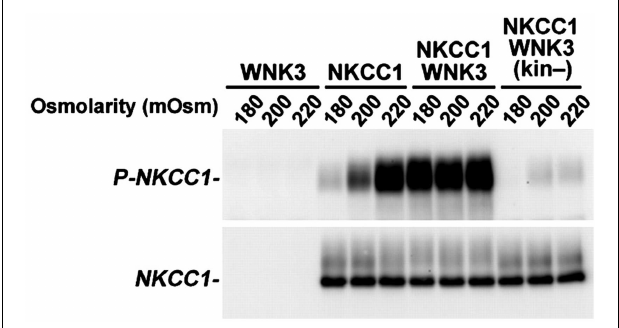
FIGURE 4 | Inhibition ofWNK3 kinase activity potently reduces stimulatory phosphorylation of NKCC1 .WNK3 regulates the phosphorylation of NKCC1. Xenopus oocytes were injected with the indicated cRNAs and incubated at varying extracellular osmolarities (180, 200, and 220mOsm). After incubation, oocytes were lysed, andWestern blotting was performed with probes for phosphorylated NKCC1 (P-NKCC1) or unphosphorylated NKCC1 (NKCC1). Phosphorylation of NKCC1 normally increases from negligible levels in hypotonic conditions (180mOsm) to complete phosphorylation in hypertonic conditions (220mOsm). Coexpression of NKCC1 with kinase-activeWNK3 results in robust phosphorylation of NKCC1 at all osmolarities, but coexpression with kinase-deadWNK3 results in marked reduction of NKCC1 phosphorylation at all osmolarities. Reprinted from Kahle et al. (2005), under their policy that allows for the use of this figure in this review. Copyright, 2005,The National Academy of